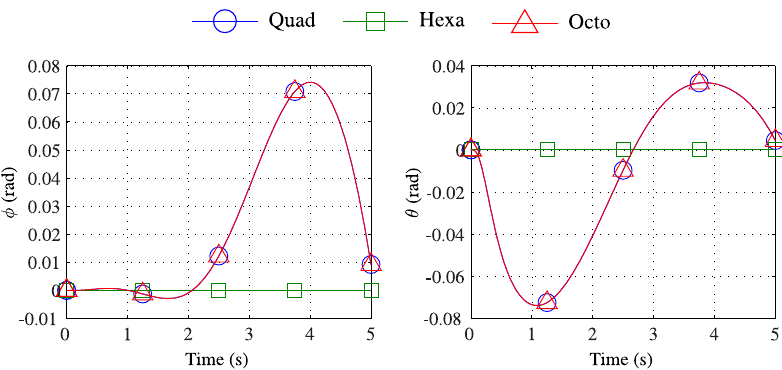
Figure 9. Dynamic response in roll and pitch for each multirotor when accurately tracking a commanded